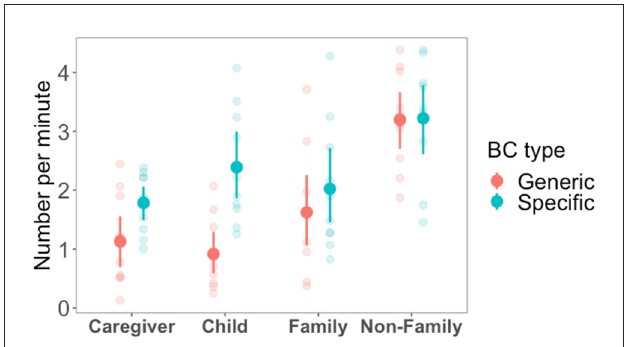
FIGURE3 The rate of BC production per minute for both the child-caregiver condition and family vs. non-family in the caregiver-adult condition. Each data point represents a participant and ranges represent 95% confidence